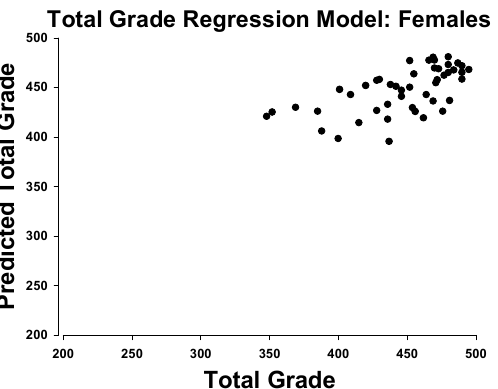
Figure 3. Actual total grade scores in females vs. the predicted value from a regression model including soda pop foot times, physical activity, Illinois agility, sit-and-reach scores, and VO 2 max. In males, the regression model for total grade scores was able to explain 4.3% of the variance. In total, 1 of the 60 subjects was excluded from the model as an outlier. Soda pop hand scores were the only contributor to the model; no other activity tests significantly improved the model fit (Figure 4).